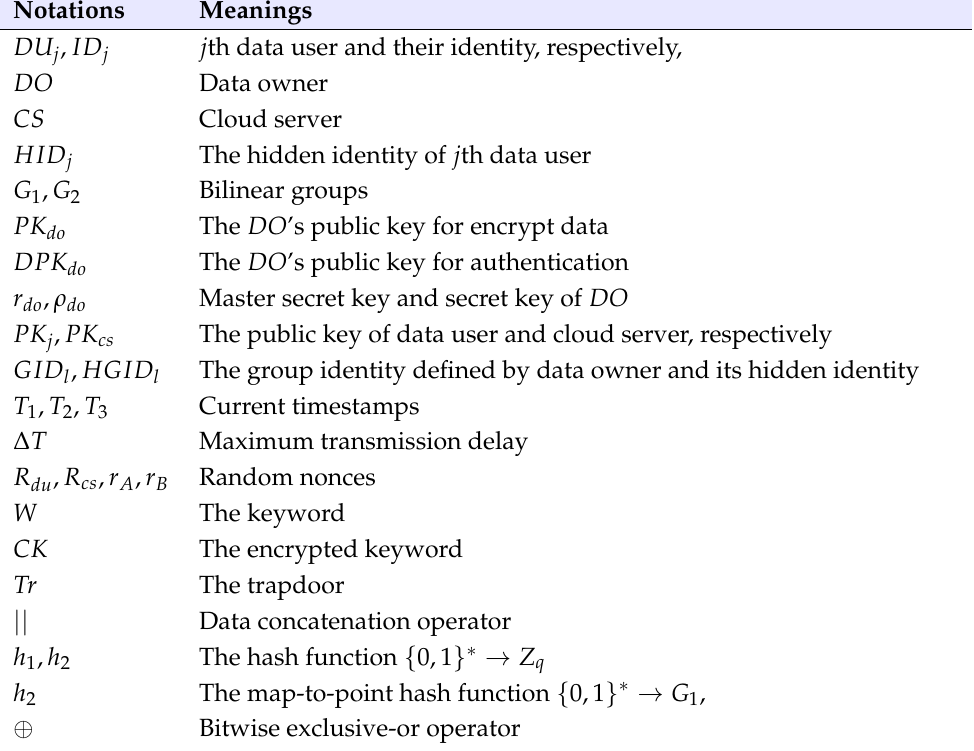
Table 1 specifies the symbols used in this paper. Table 1. Notations used in this